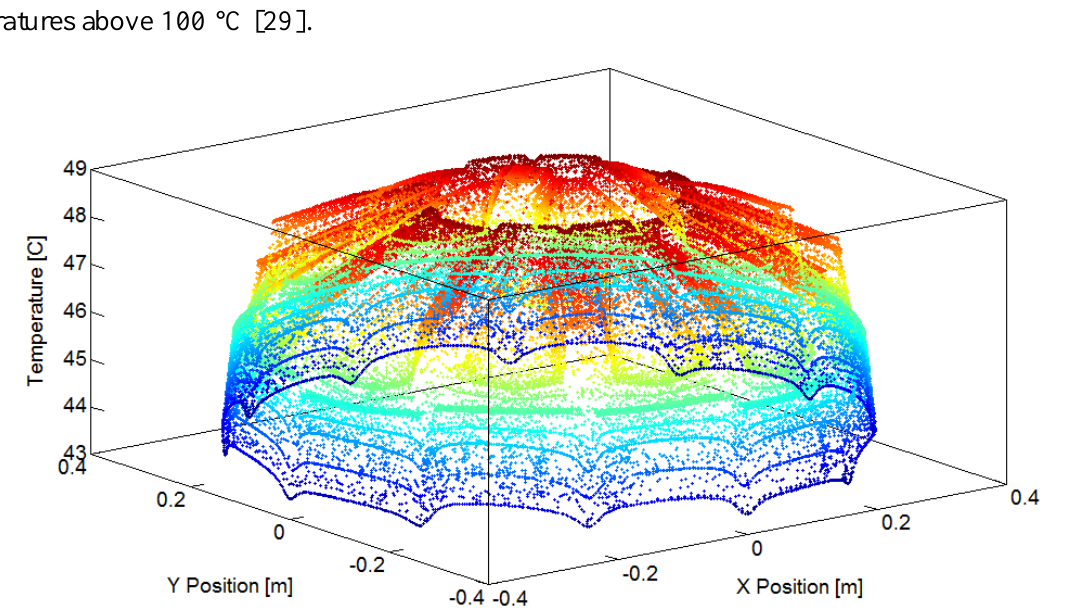
Figure 14. Maximum temperature in the